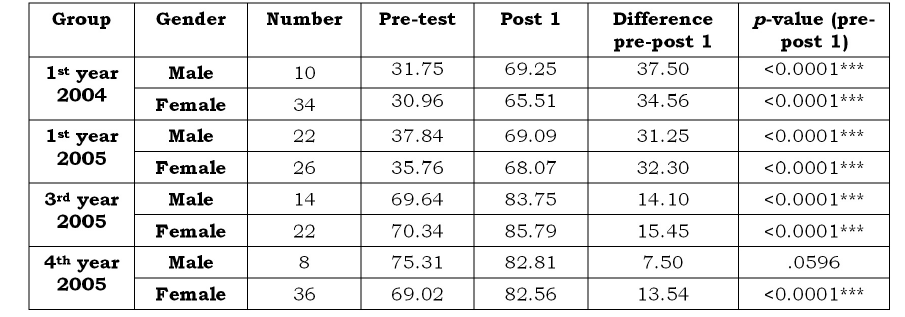
group, 1 st year 2004; 1 st , 3 rd and 4 th year